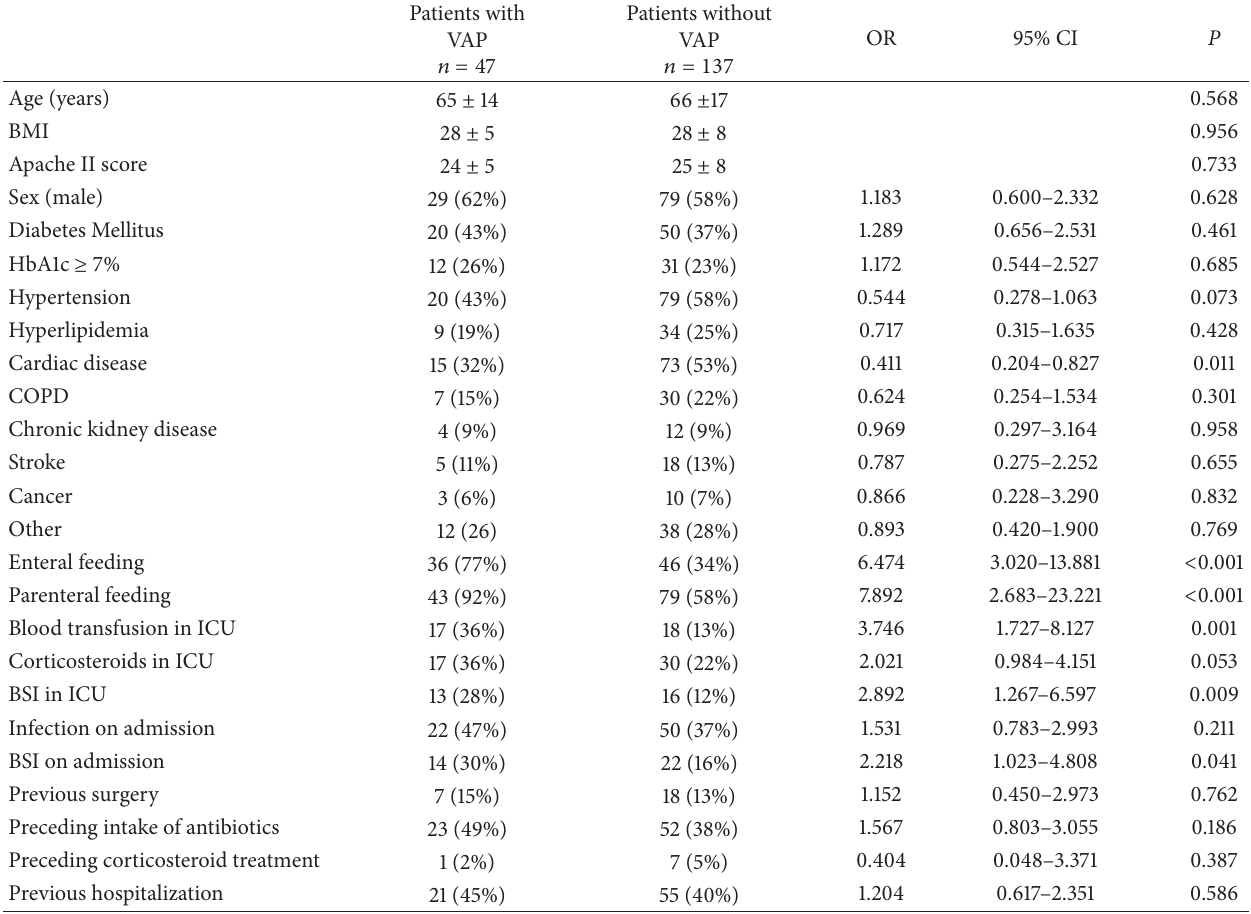
Table 3: Risk factors for ventilator-associated pneumonia (VAP).